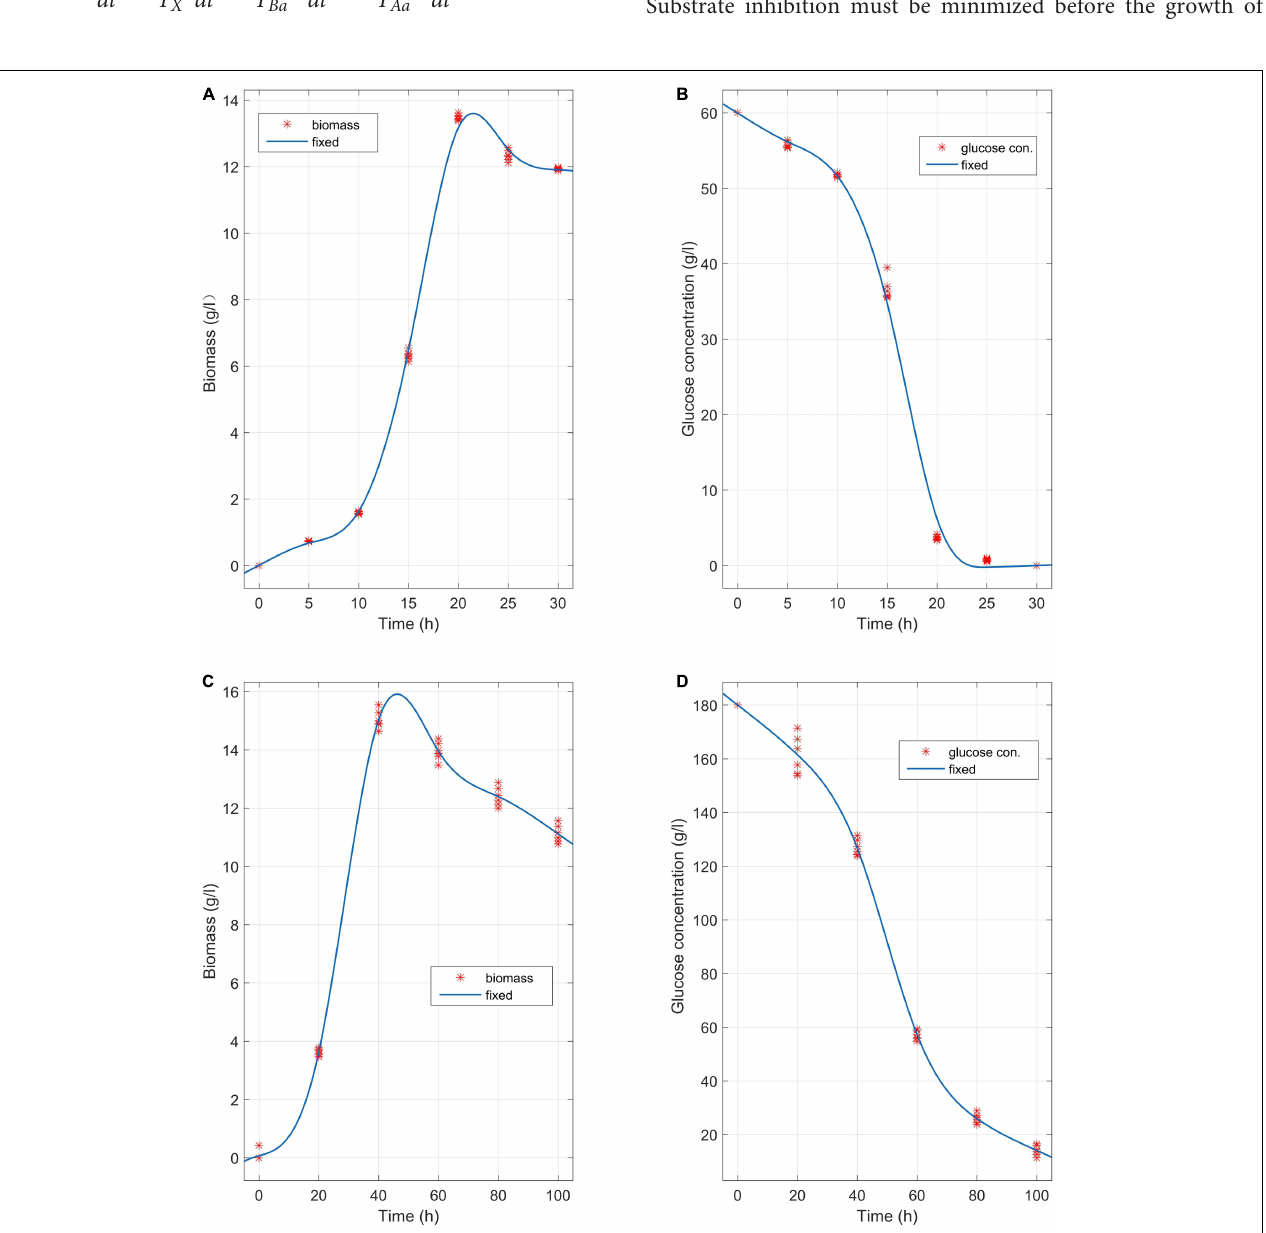
FIGURE 3 | Biomass change and glucose consumption at different time points in the biofermentations of C. tyrobutyricum mutants in media with a concentration gradient of 60 g/L and 180 g/L glucose, respectively. (A) The mutants’ butyric and acetic acid productivity at 37 ◦ C, pH = 6.0 over 45 h of biofermentation ( n = 6). (B) Glucose consumption (60 g/L) at different time points in the biofermentation of the C. tyrobutyricum mutant (45 h). (C) The mutants’ butyric and acetic acid productivity at 37 ◦ C, pH = 6.0 over 120 h of biofermentation ( n = 6). (D) Glucose consumption (180 g/L) at different time points in the biofermentation of the C. tyrobutyricum mutant (120 h). Experimental (red asterisks); simulated (blue lines).